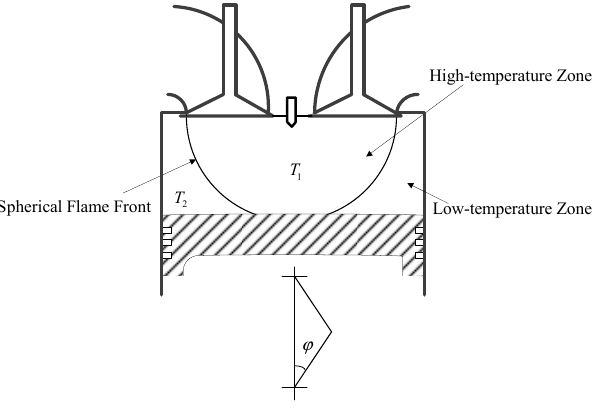
Figure 1. In-cylinder space division of the SI engine.